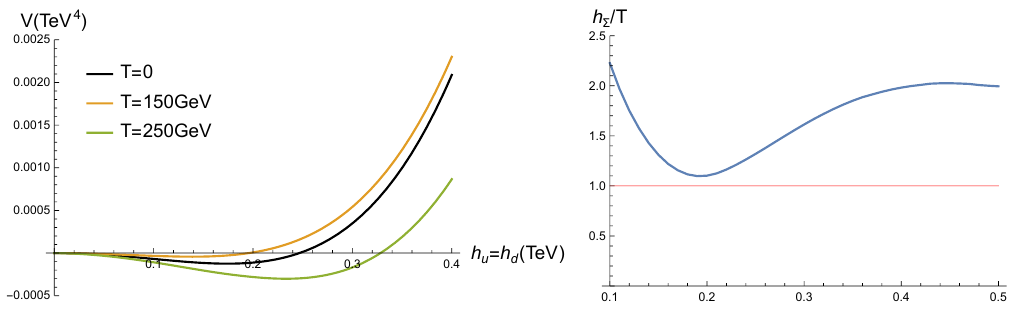
Figure 4 . Left panel: the Higgs potential in the h u = h d direction at various temperatures in the presence of SNR states, for n χ = 10 , µ χ = 650 GeV , µ H = − 130 GeV , Λ = 2 . 5 TeV , c χh = 3 . 2 , tan β = 1 and a common heavy Higgs mass scale m H,H corresponding Higgs VEV h Σ =